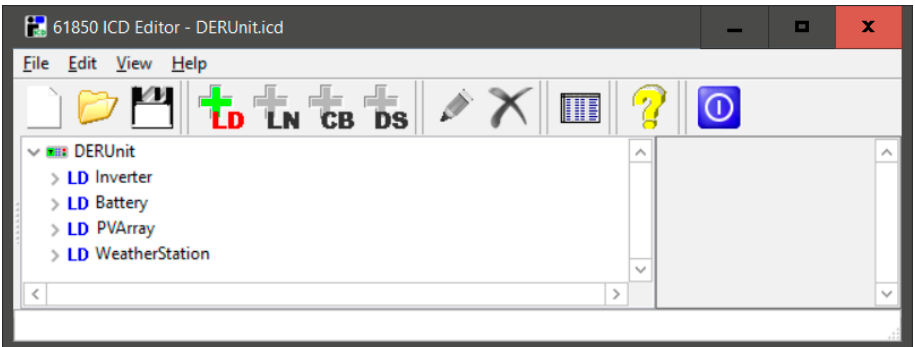
Figure 7. Editing ICD file for a DER in 61850 ICD editor.